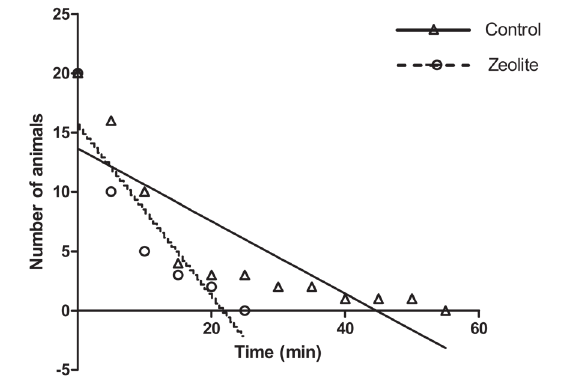
Fig. 1. Linear regression between the number of Ancistrus triradiatus that maintained the swimming axis and time of exposure to hyperosmotic saline solution for control and zeolite groups.